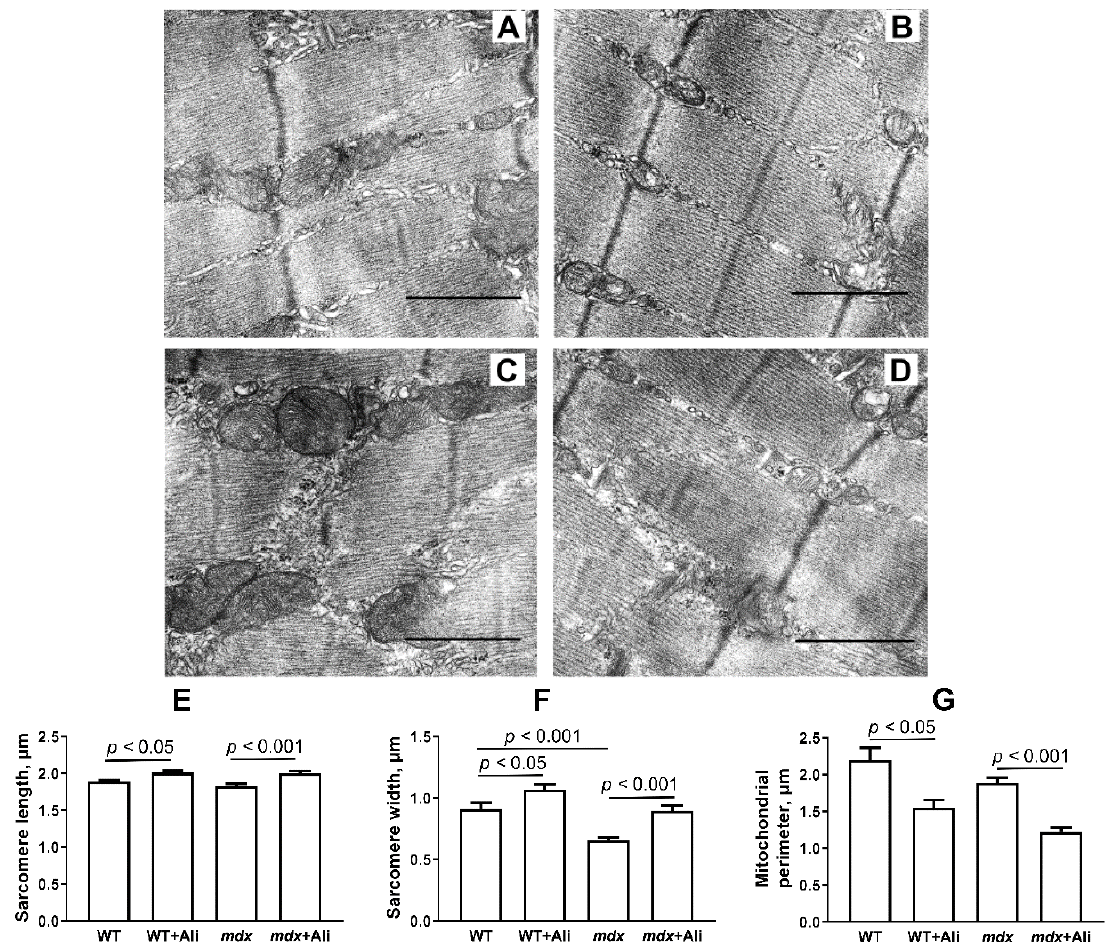
Figure 4. Representative electron micrographs of skeletal muscle tissue (quadriceps) from WT ( A ), WT+Ali ( B ), mdx ( C ), and mdx +Ali ( D ) groups of mice. The bar is equal to 1 μ m. Graphical representation of micrograph profiles: sarcomere length in μ m ( E ), sarcomere width in μ m ( F ), and mitochondrial perimeter in μ m ( G ). The number of examined fields of view in the groups varies from 40 to 50.